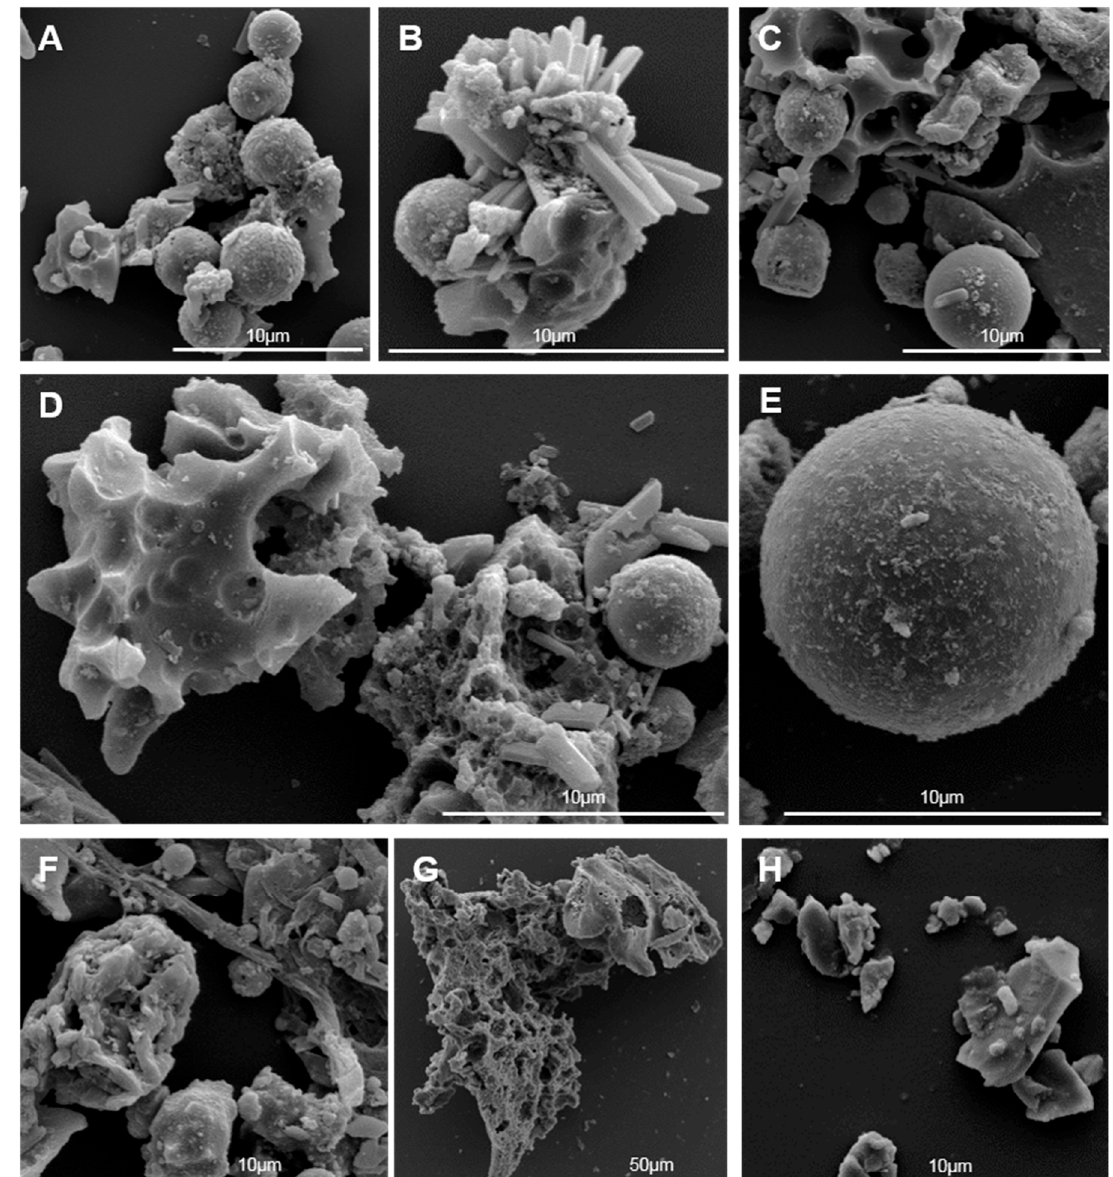
Figure 1. Field emission scanning electron microscope (FE-SEM) micrographs of size-separated coal fly ash (CFA) particles collected from Svalbard. ( A ) Particulate matter (PM) 2.5 CFA; ( B ) PM 2.5 CFA containing gypsum crystals; ( C ) PM 2.5 CFA with large glass structures; ( D ) PM 10 CFA containing many morphologies; ( E ) PM 10 CFA sphere; ( F ) PM 10 CFA with fibrous morphology; ( G ) bulk CFA; ( H ) crushed magnetite.